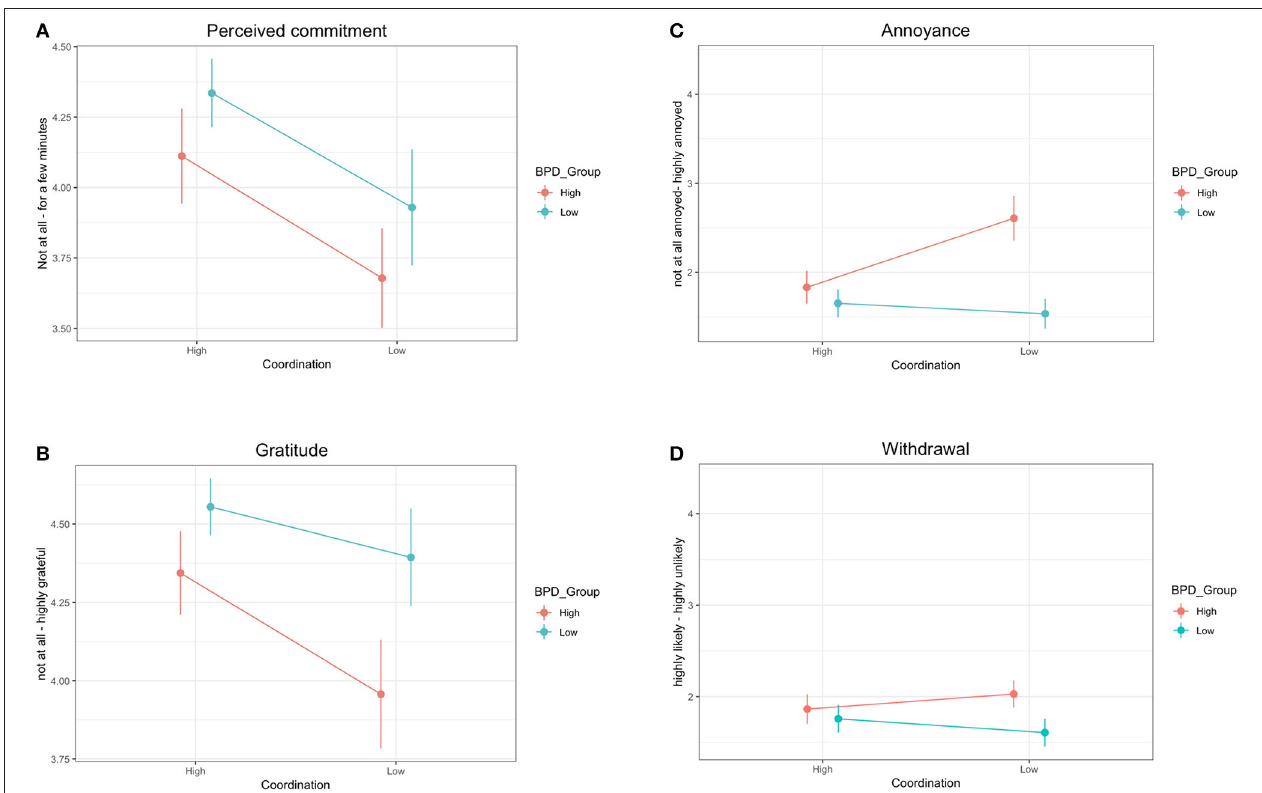
FIGURE 1 | Results to the four test questions for the High BDP and Low BPD groups in the High. Coordination and Low Coordination conditions. Error bars represent the confidenceintervals. (A) shows participants’ responses to the perceived commitment question (“How long would you expect Thomas to continue to help?”). (B) shows responses to the gratitude question (“How would you feel if Thomas continued helping until all the sand had been cleaned up?”). (C) shows responses to the annoyance question (“If Thomas’ phone rang and he took the call, how would you feel?”). (D) shows responses to the withdrawal question (“If Thomas took the phone call, how likely would you be to help him in the